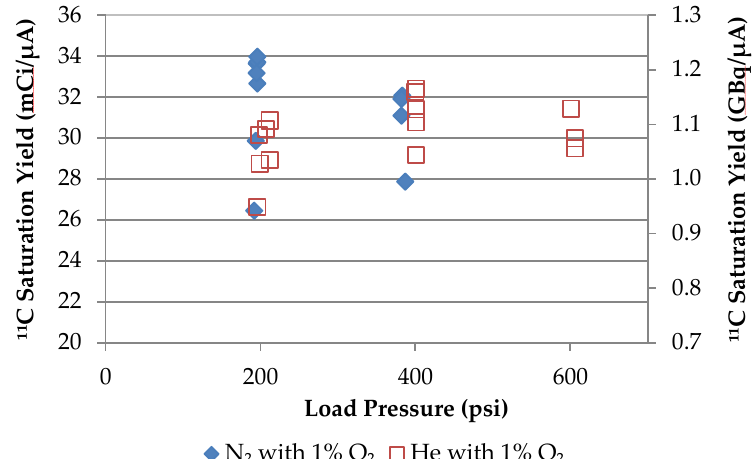
Figure 12. 11 C saturation yield for the BN-131 target at 5 μ A.